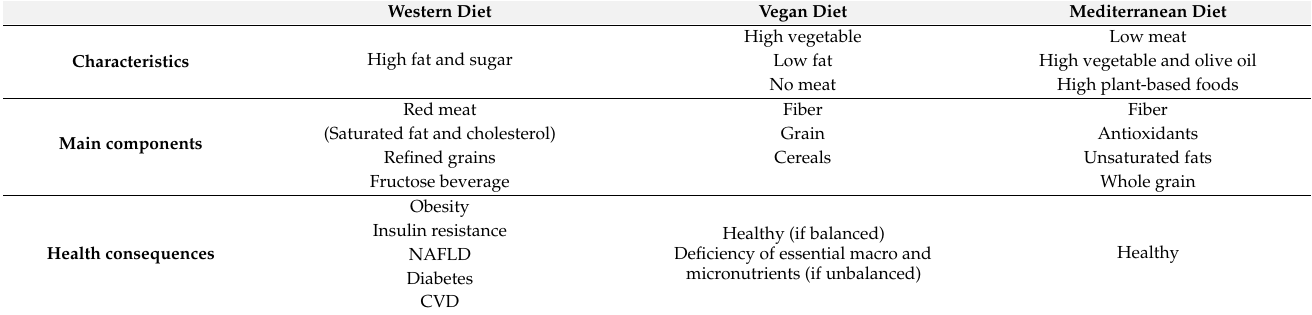
Table 2. Principal features of Western diet, Vegan diet, and Mediterranean